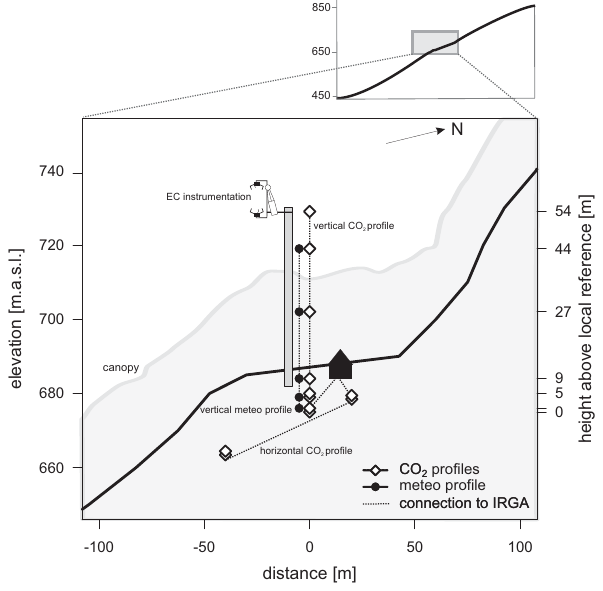
Fig. 2. Experimental set-up of EC flux and advection measure- ments. 675ma.s.l. is used as local reference zero height. Note that the x- and y-axis have different scales. For details see text.